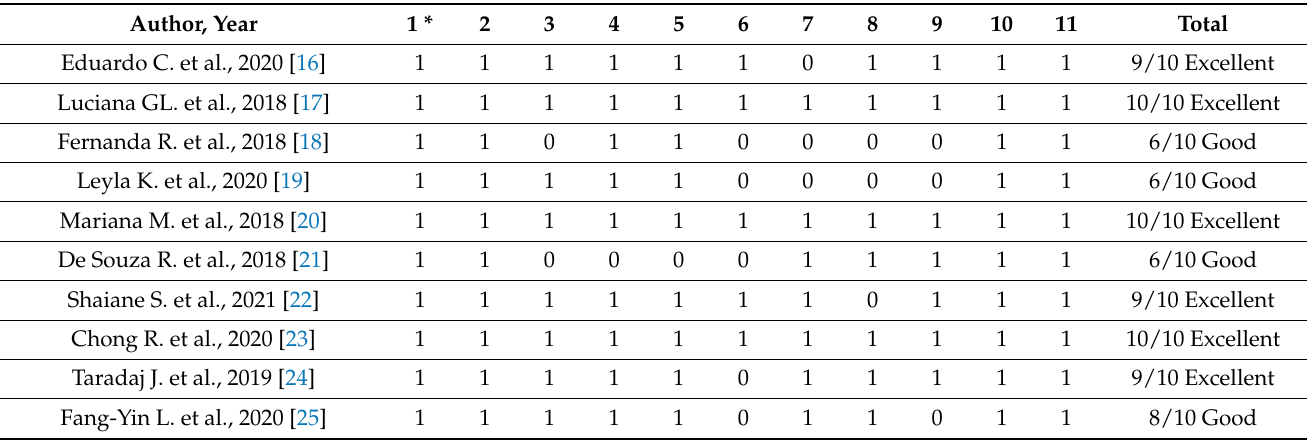
Table 2. Study of the methodological quality of the RCTs with the PEDro scale.